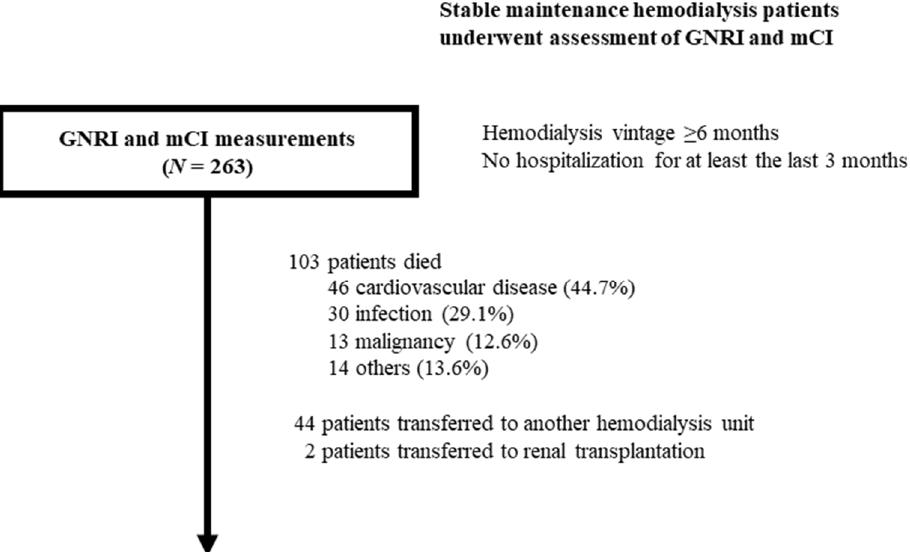
Figure 1. Flow diagram of the present study.